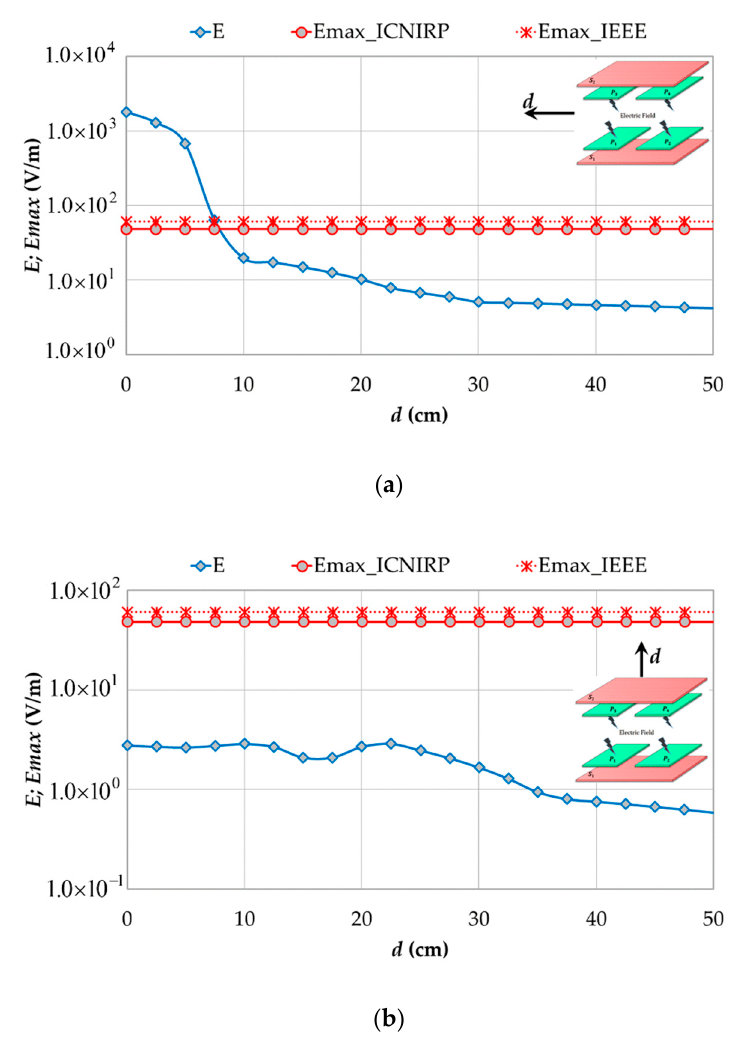
Figure 24. The EF emission of shielded-CPT system: ( a ) beside the coupling interface, ( b ) behind the shield plate.